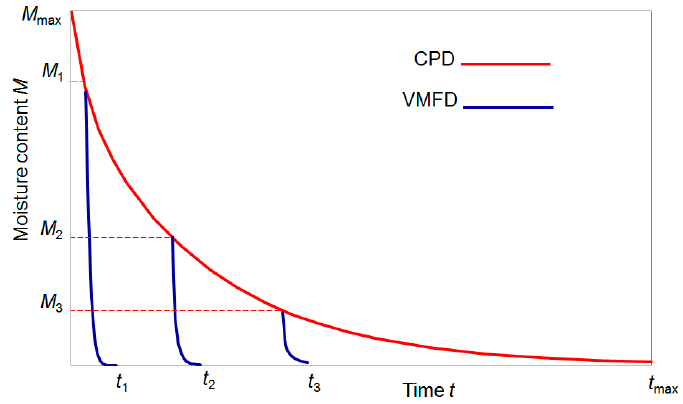
Figure 5. Drying kinetics for combined drying consisted in CPD until different levels of moisture contents followed by VMFD. M 1 , M 2 and M 3 represent a high, medium and low moisture contents obtained after CPD whereas t 1 , t 2 and t 3 denote total drying times of combined drying consisted of CPD until M 1 , M 2 and M 3 followed by VMFD.